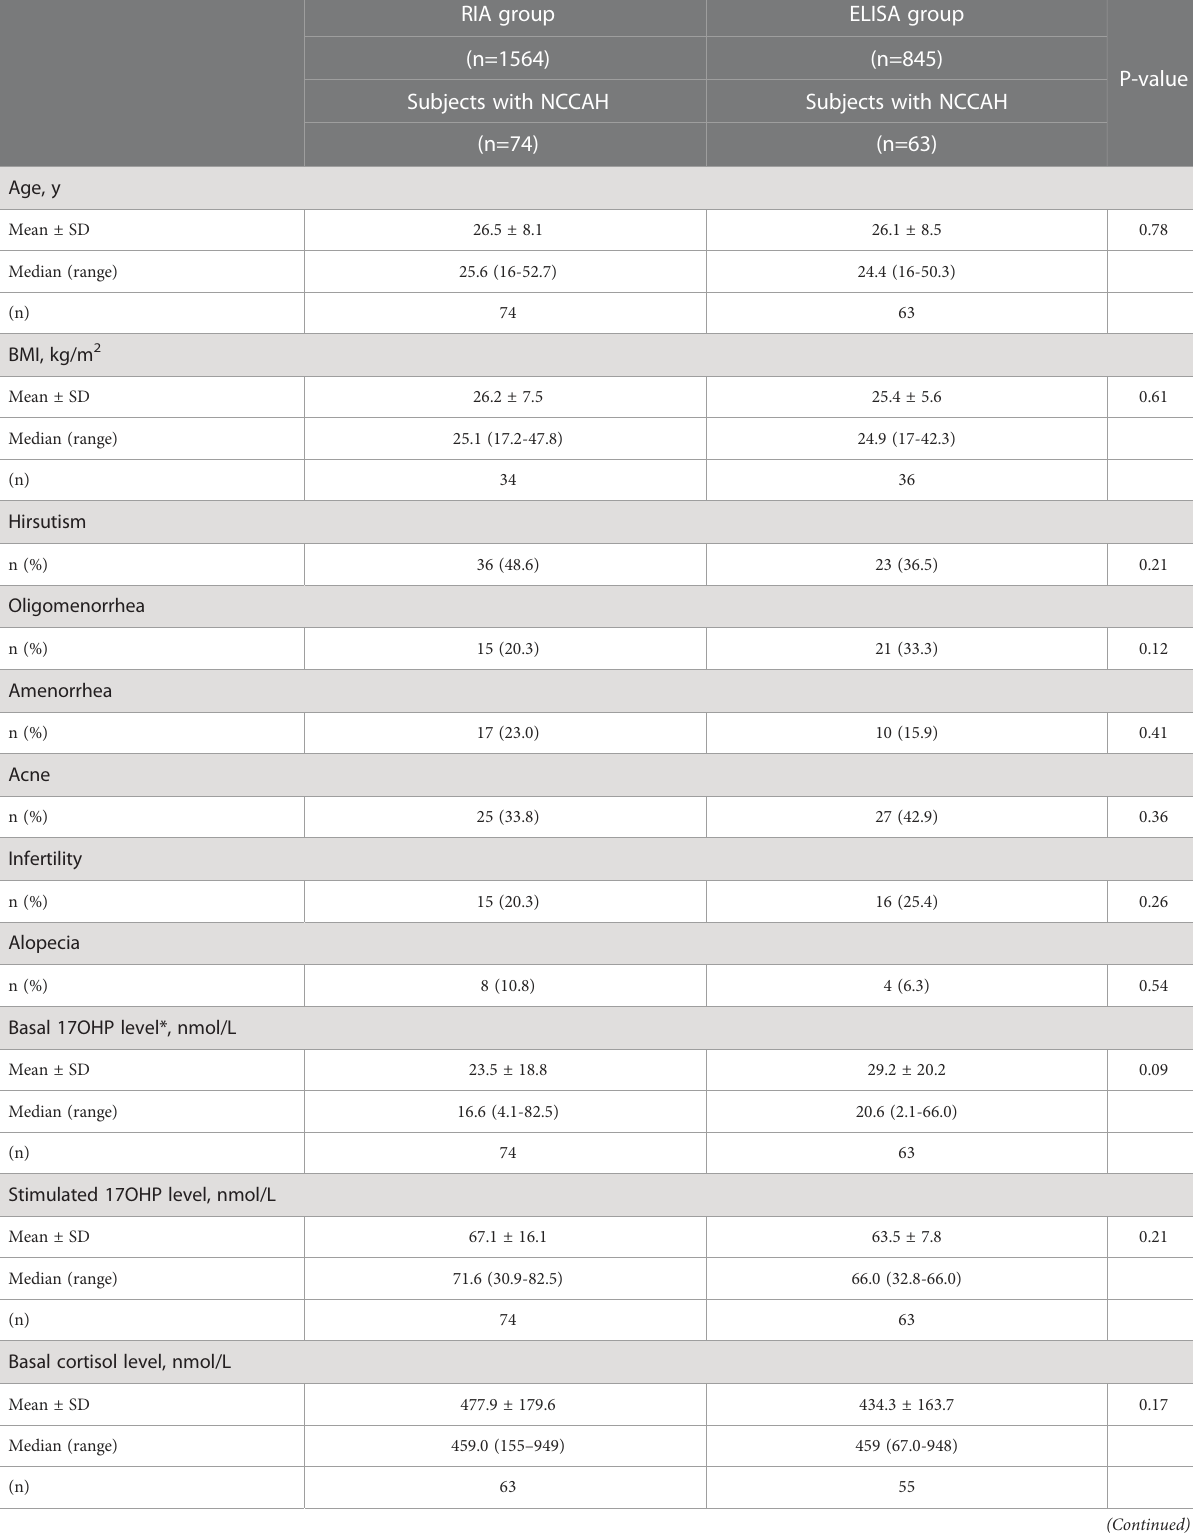
TABLE 3 Comparison of clinical and biochemical characteristics among women with NCCAH from the RIA and the ELISA